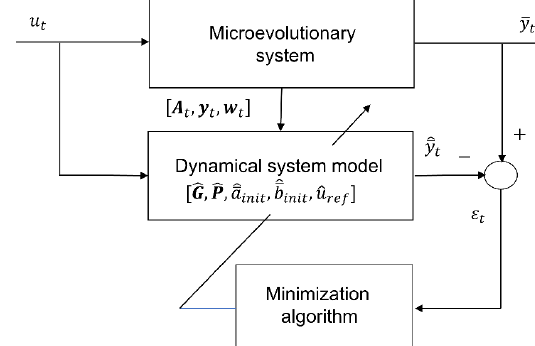
Figure 1: Block diagram of microevolutionary PEM for SISO system, with dynamical tuning model based on an intercept-slope reaction norm model with mean traits ¯ a t and ¯ b t .